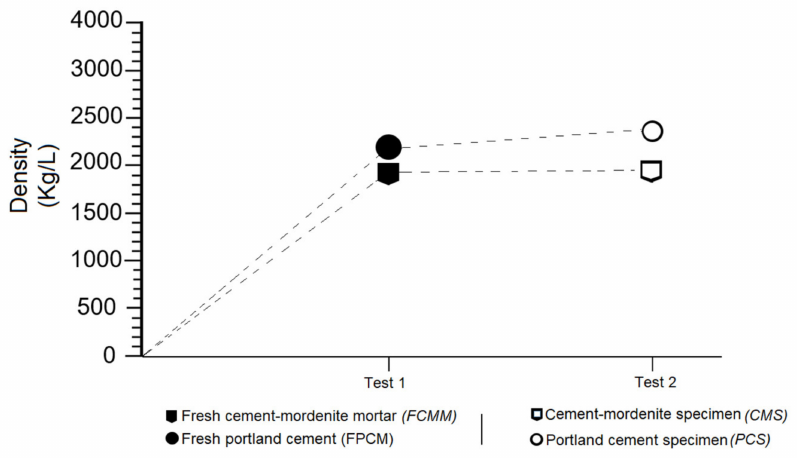
Figure 11. Density of fresh mortars (FCMM and FPCM) and specimens (CMS and PCS).